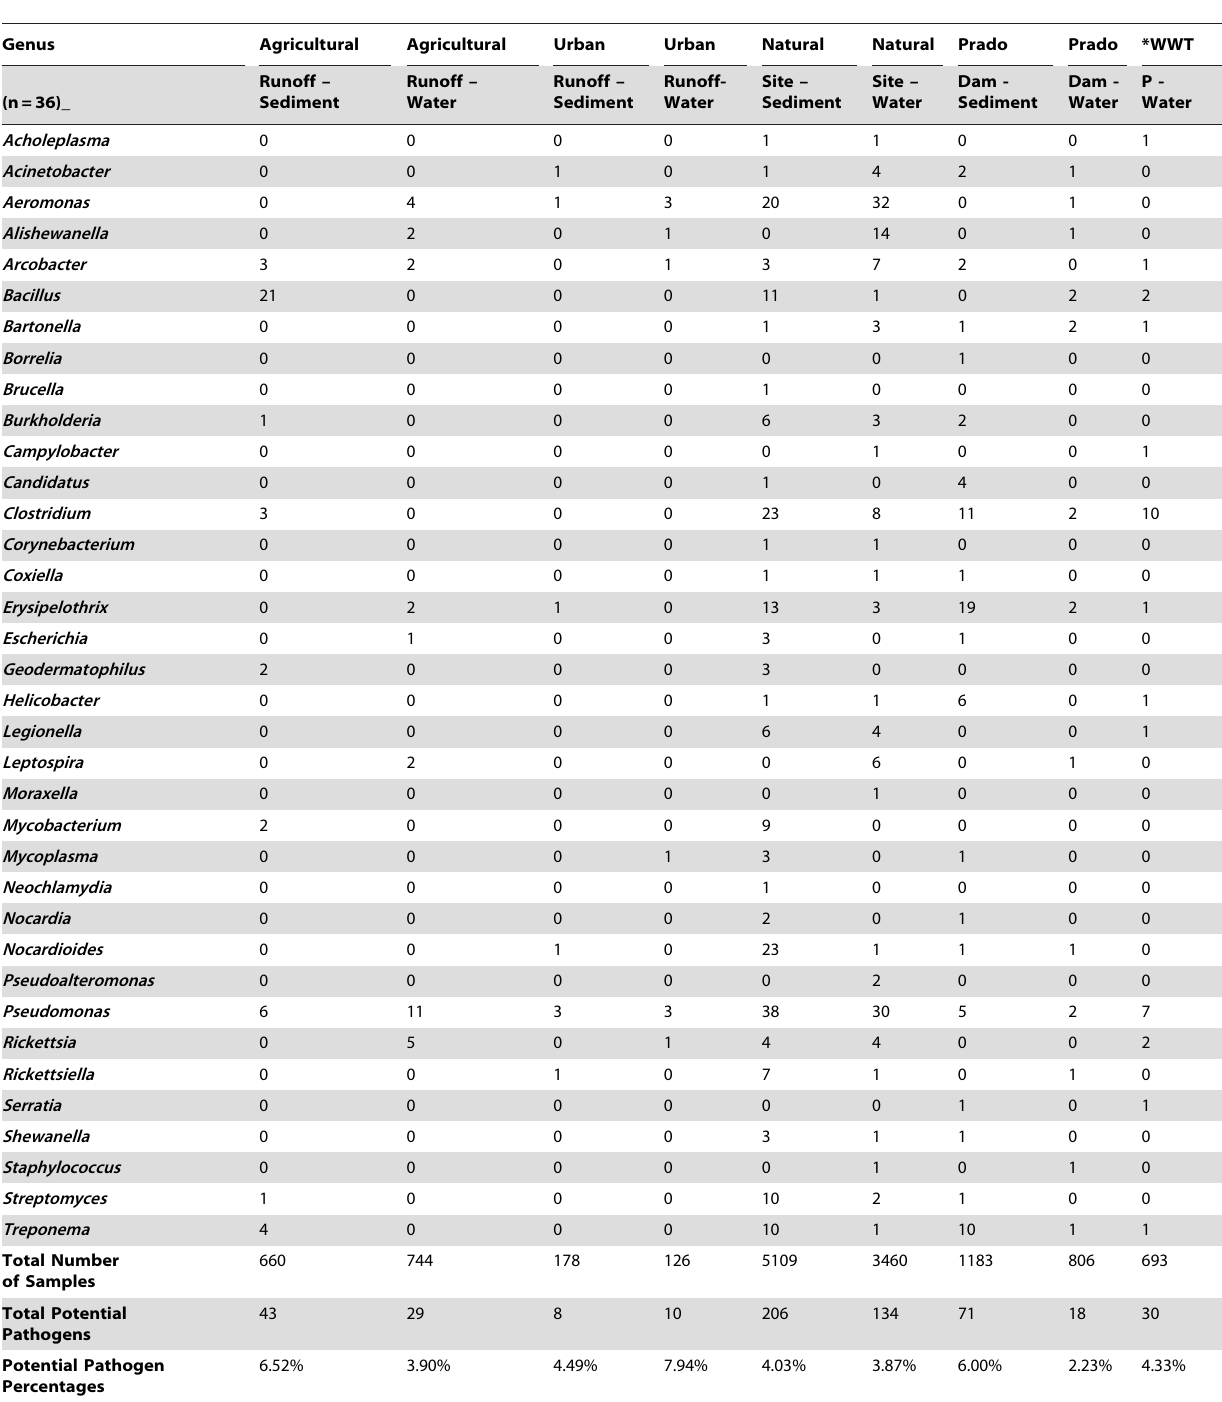
Table 2. Number of sequence tags assigned to potential pathogenic genus from Santa Ana River watershed as determined by 454 pyrosequencing using RDP Classifier